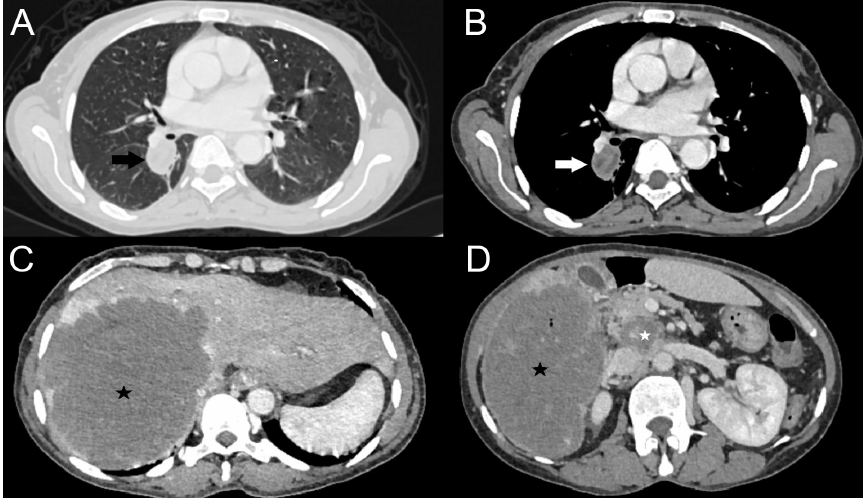
Figure 3. A-D. Axial contrast-enhanced computed tomography (CT) images at the level of the lung (A and B) and liver (C and D) show a large alveolar echinococcosis lesion located in the right lobe of the liver (black stars in C and D). Alveolar echinococcosis metastases in the right lung are shown in the same patient (black and white arrows in A and B). In addition, alveolar echinococcosis involvement is observed in the uncinate process of the pancreas (white star in D).